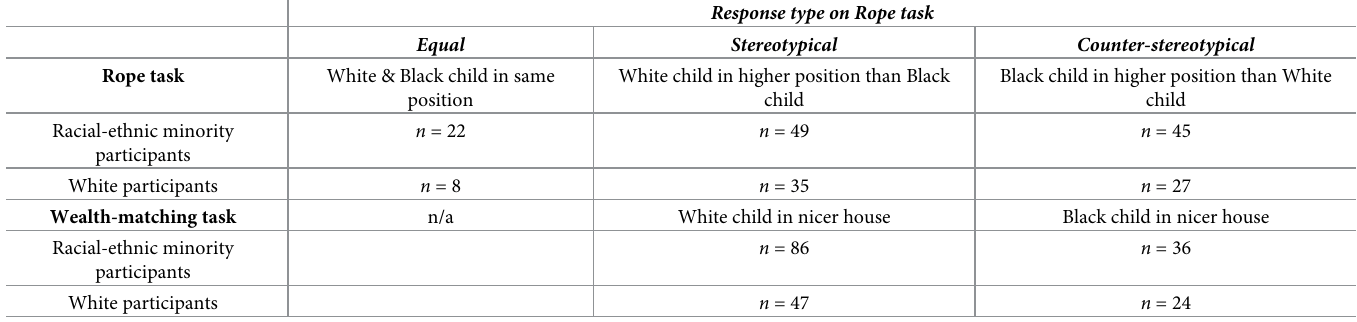
Table 2. Number of Study 2 participants who provided a given response type for the rope task and wealth-matching task, separately for White and racial-ethnic minority participants. Table includes only participants whose parents reported child race ( n =